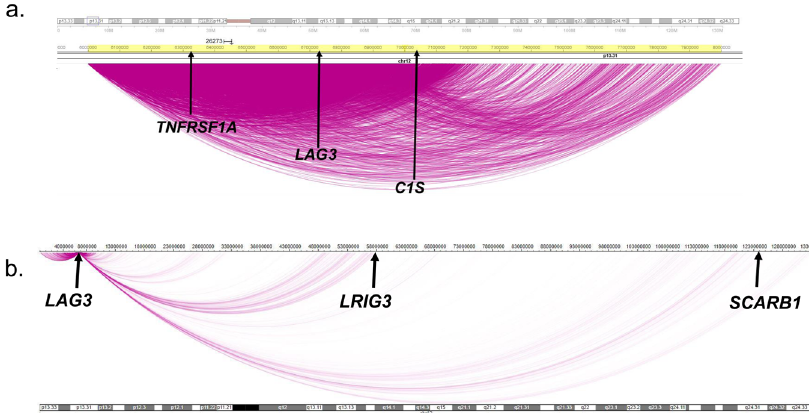
Fig. 4 Hi-C near cis and cis interactions from the LAG3 locus on chromosome 12: MESA. We performed in situ Hi-C analysis in EBV-transformed B lymphoblasts from two female (one African-American and one Hispanic) MESA carriers homozygous for the SCARB1 rs10846744 reference G and two female (one African-American and one Hispanic) MESA carriers homozygous for the effect C alleles. The in situ Hi-C analysis was performed as recommended by the 4D Nucleome Consortium using the four base pair cutter DpnII restriction enzyme and high read depth next gen sequencing (NGS) to maximize resolution of the high frequency interactions between chromatin contacts (https://www.4dnucleome.org/protocols.html). Each cell library underwent deep NGS at read depths between 1.4 – 3.3 billion and this was done independently twice as technical replicates for each cell library. Bioinformatic analysis was conducted using Hi-C Pro software with binning of the matrix at different resolutions and iterative correction and eigenvector decompensation normalization of the matrix for each of the four libraries 62,63 . Readouts were all valid paired-end reads and corresponding high frequency contact interaction scores. We then used data generated from the million binning resolution and fi ltered it based on the LAG3 chromosomal coordinates (chr12:677250-6778455) using human assembly GRCh38/hg38 (https://genome.ucsc.edu/cgi-bin/hgGateway), which yielded both cis (chr12) and trans interactions. We set interaction scores at the LAG3 locus arbitrarily at 1 and then compared interaction scores from direct and indirect cis and trans interactions. Student t-test was performed with P ≤ 0.05 considered statistically signi fi cant. The results shown are representative from one of the MESA cell lines, with the schematic representing the near cis (panel a ) and cis interactions (panel b ) from the LAG3 locus on chromosome